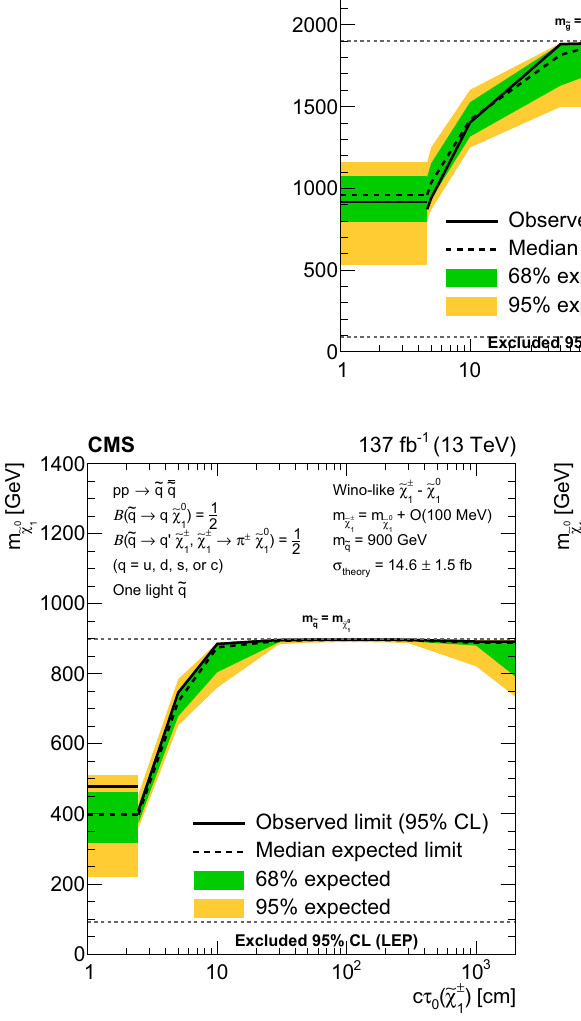
= mass, with m ˜ χ ± decays before struction inefficiencies, which may arise when the ˜ χ ± 1 1 1 the CMS tracker, and therefore shows better sensitivity to scenarios proper decay length, for 1 ) compared to the disappearing track search, with very small c τ 0 ( ˜ χ ± 1 based on median expected limits. The horizontal dashed lines at (upper) m ˜ g = m ˜ χ 0 and (lower) m ˜ q = m ˜ χ 0 bound the mass range in which 1 1 the decays are kinematically allowed. If all kinematically allowed ˜ χ 0 1 ≤ m ˜ ≤ m ˜ masses ( m ˜ χ 0 g , or m ˜ χ 0 q ) are excluded, the curves, including 1 1 68 and 95% expected, tend to overlap. The band at masses of the ˜ χ 0 1 below 91.9 GeV represents the region of the mass plane excluded at the CERN LEP [151]. Signal cross sections are calculated at approximately NNLO+NNLL order in α S [136–147], assuming decay branching frac- tions ( B ) as indicated in the